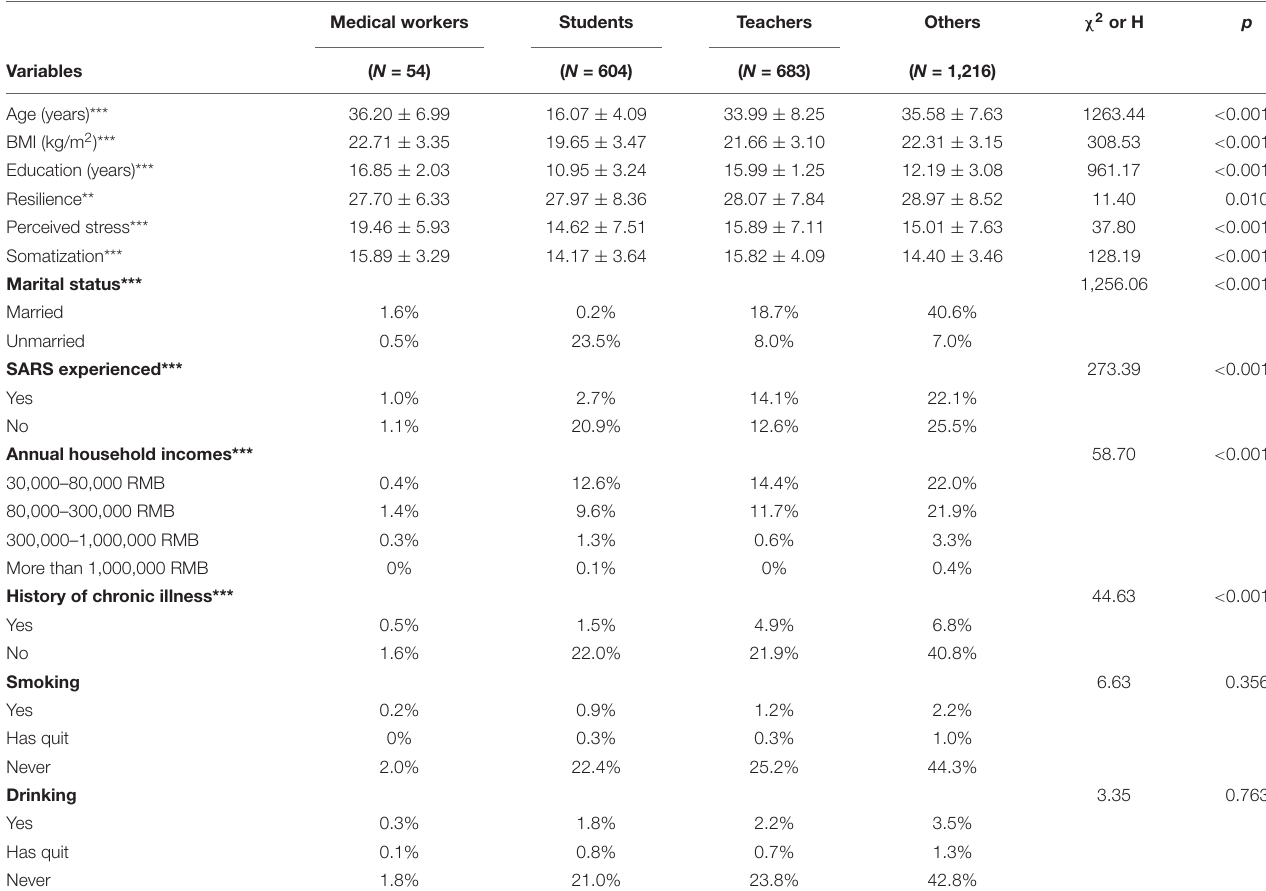
TABLE 2 | Descriptive statistics and differences of occupation for all variables.